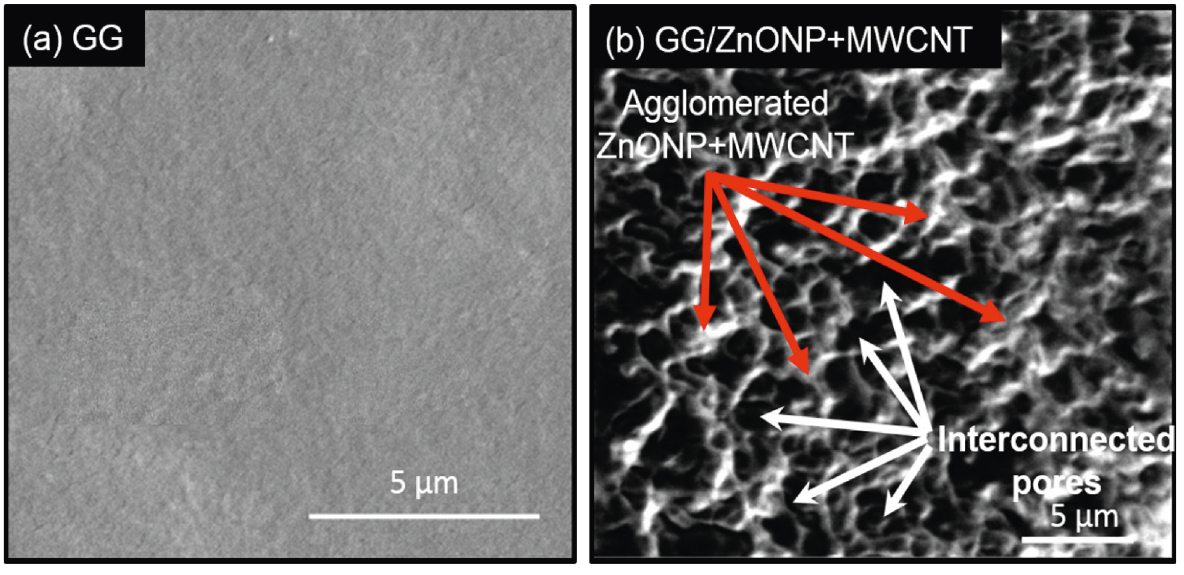
Figure 4: SEM images of (a) GG film and (b) GG/ZnONP+MWCNT bionanocomposite film.